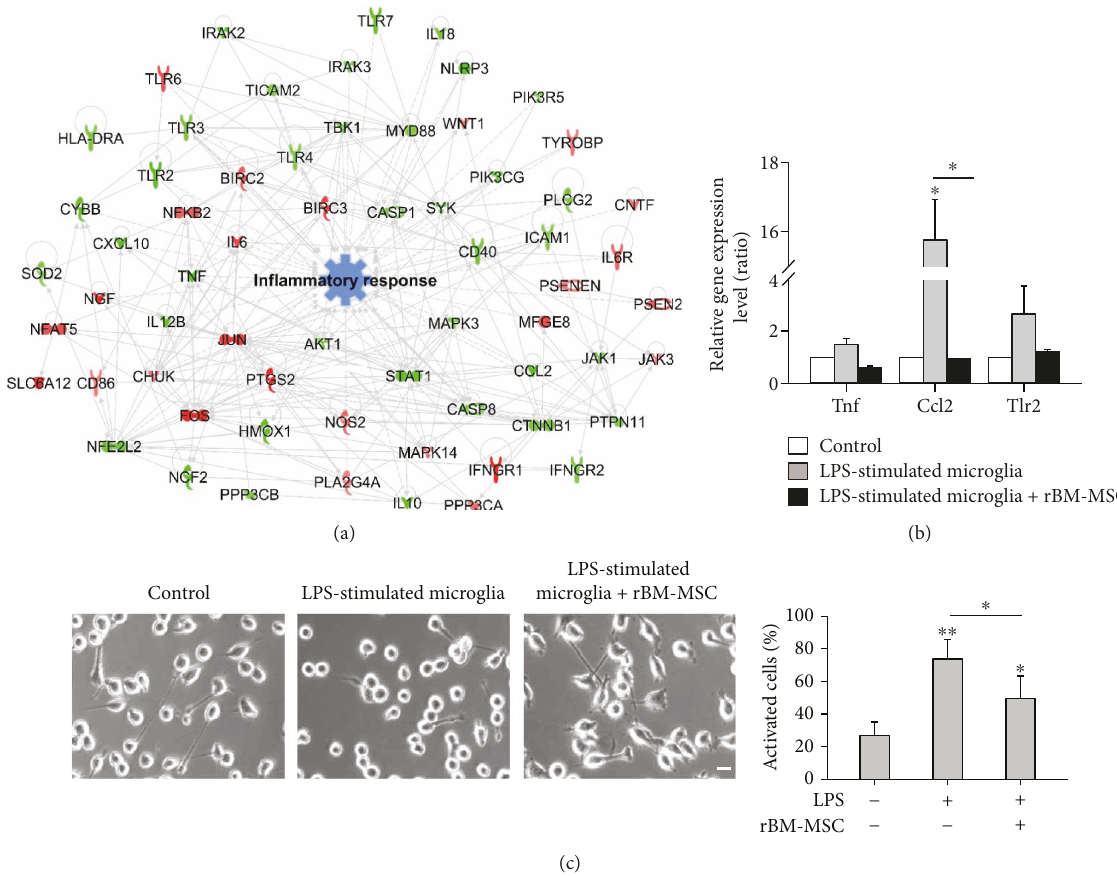
Figure 5: Reduced in fl ammatory response in LPS-stimulated microglia cocultured with rat bone marrow-derived mesenchymal stem cells (rBM-MSCs). (a) Gene network related to in fl ammatory response was constructed, and cellular function was predicted algorithmically using Ingenuity Pathway Analysis. Red and green areas indicate up- and downregulated genes, respectively. Di ff erentially expressed genes were obtained from microarray data ( > 1.2 fold-change). (b) Quantitative real-time PCR analysis of gene expression-related in fl ammation in LPS-stimulated microglia cocultured with rBM-MSCs compared to control (microglia only). (c) Activated microglia were counted in light microscopy images and quanti fi ed as the percentage of activated microglia/total cell number. Cells at the edge of the images were not counted. Scale bar: 20 μ m. ∗ p < 0 05 and ∗∗ p < 0 01 versus control (microglia